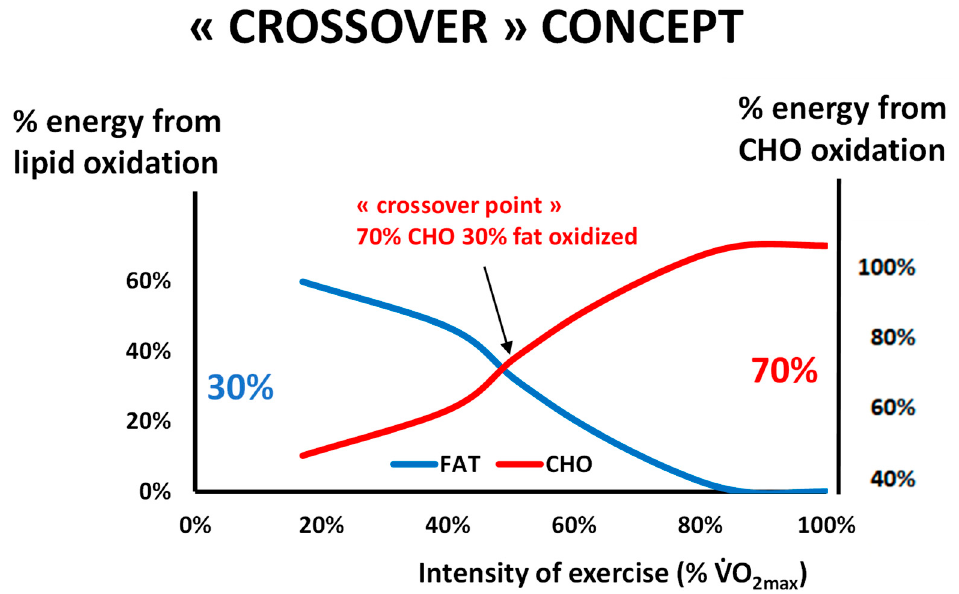
Figure 1. The classical picture of Brooks and Mercier’s “Crossover concept” redrawn from our personal database of more than 5000 exercise calorimetries (see text). This hypothesis assumes that there is a major shift in the balance of substrates used for oxidation during exercise grossly around 50% of the maximal aerobic capacity, when carbohydrates represent more than 70% of the sources of energy for the exercising body. Oxidative use of fat culminates below this level, and close to it or slightly above it, blood lactate increases and the ventilatory threshold occurs. Note that the ordinates for % of fat oxidation and % of CHO oxidation are not symmetric, in order to better visualize the crossover. In a series of more than 5000 exercise calorimetries, we find that the crossover point is, on average, at 55.1% of VO 2max but exhibits a wide variability among individuals.